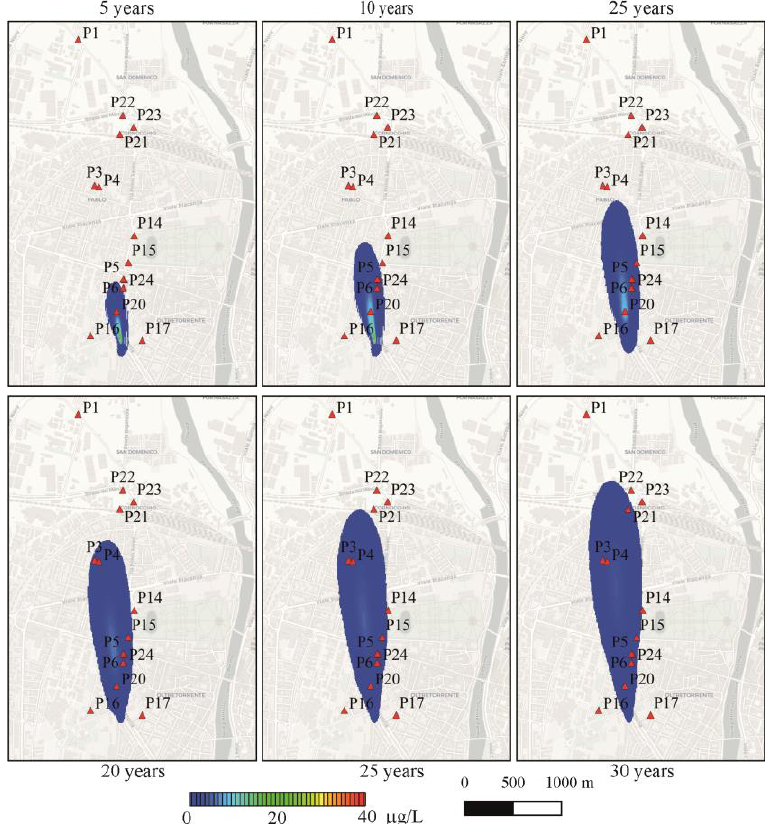
Figure 11. Groundwater contaminant transport. Example of a transport simulation starting from a hypothetical contaminant source.